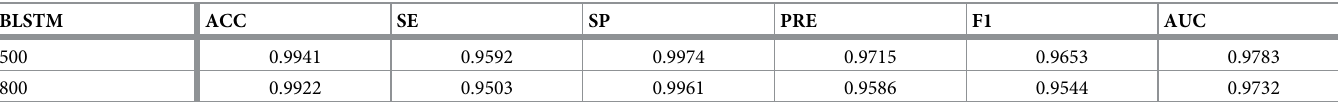
Table 9. BLSTM results (1 st experiment).